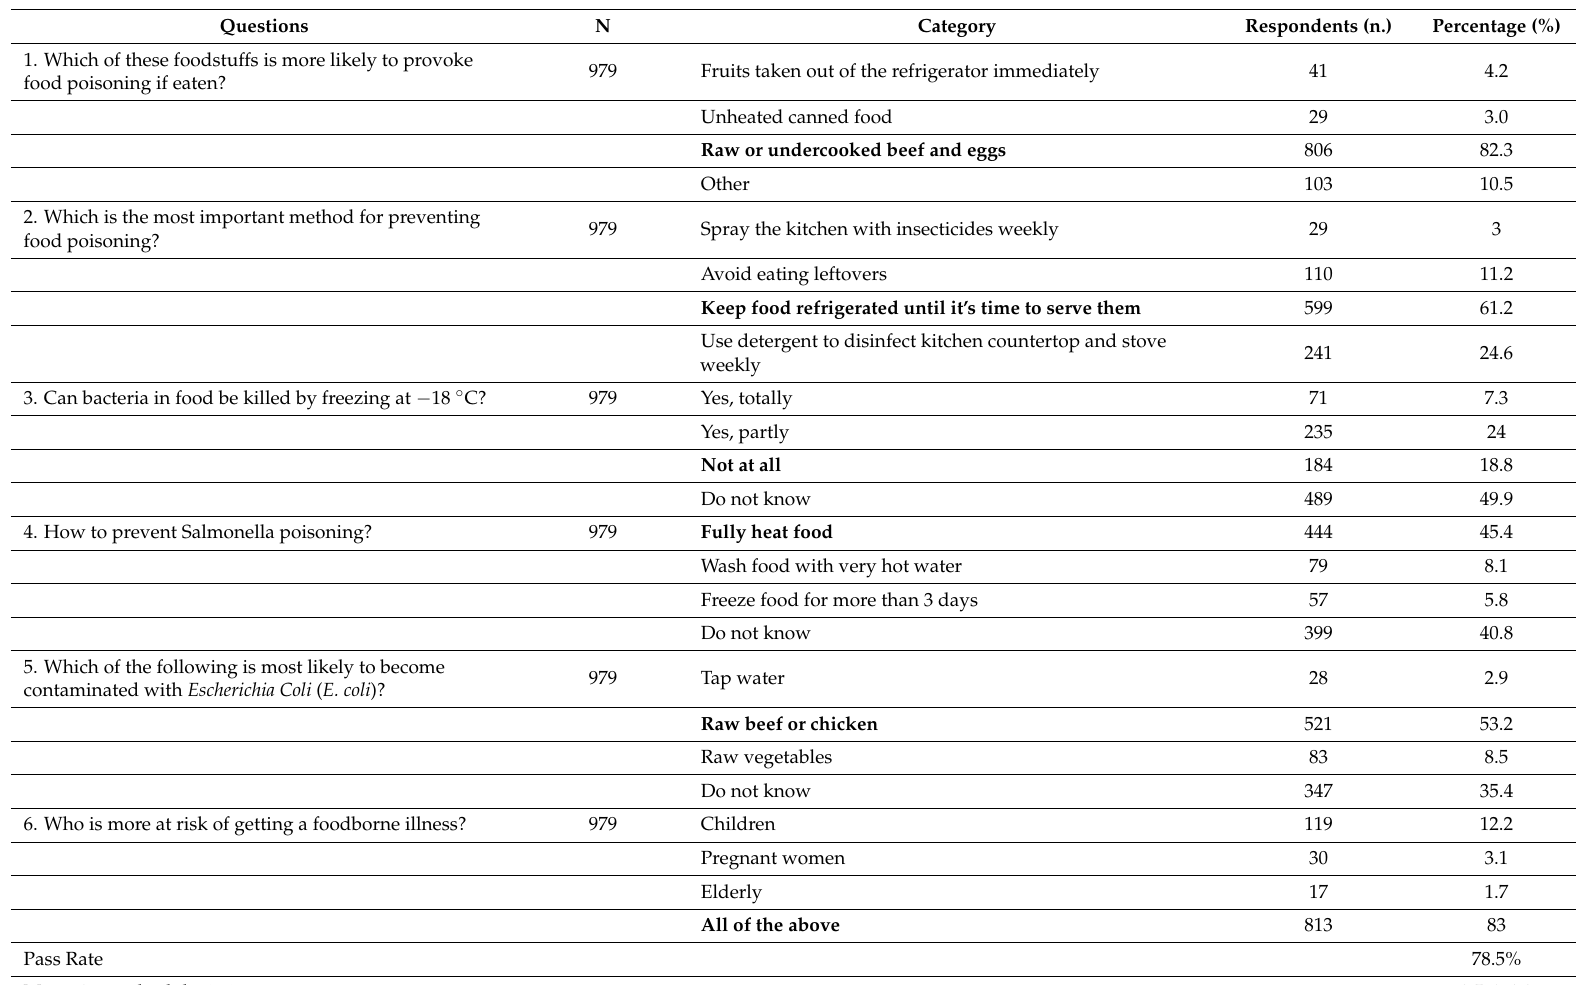
Table 6. Respondents knowledge on food poisoning, pass rate, mean score, and standard